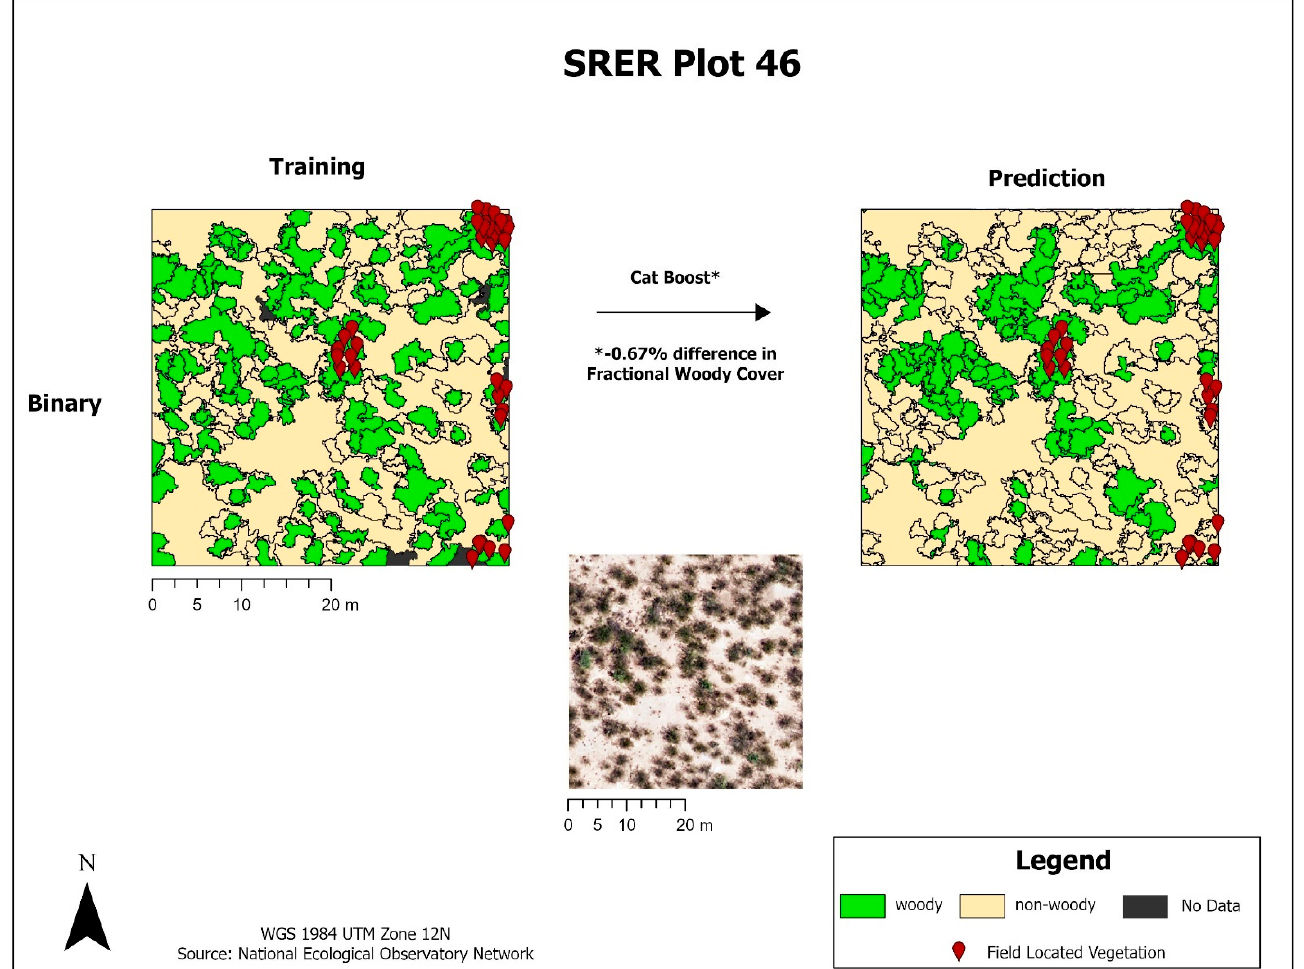
Figure 7. Cat Boost predictions for Plot 46. Multiclass is not shown, as it was not supported by the Cat Boost model. As observed in the XGB model, less-green live vegetation is being classified as non-woody and areas of woody vegetation are being predicted in a more clustered pattern compared to training data.